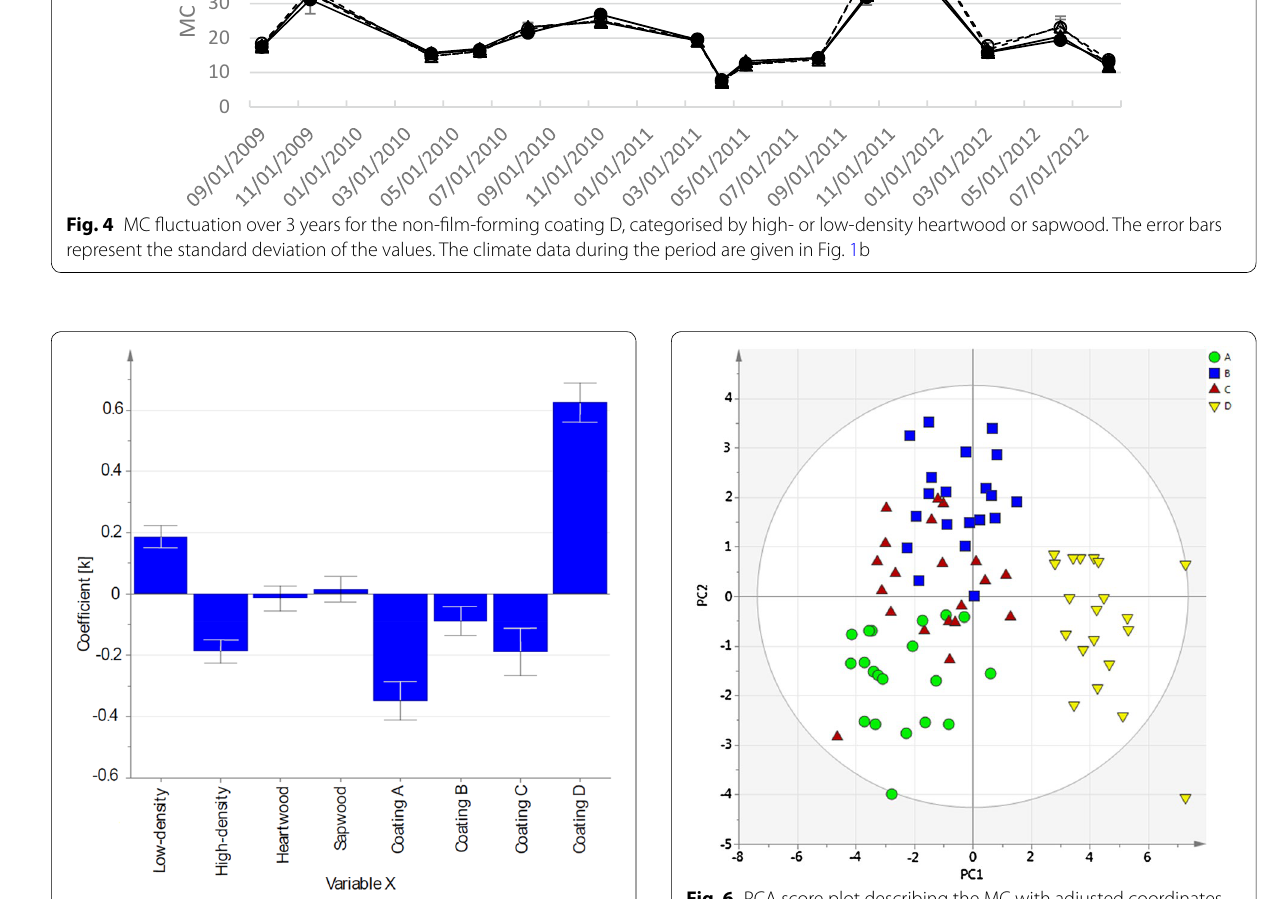
Fig. 5 Linear regression model (Eq. 1, MC = MC mT + Xk + F ) with a normalised linear coefficient ( k ) relative to the average MC of all replicates (MC mT ). The error bars represent 95% of the values. A negative k value indicates that the variable X contributes to a lower MC relative to the MC mT . A–D: coating systems described in Table 2